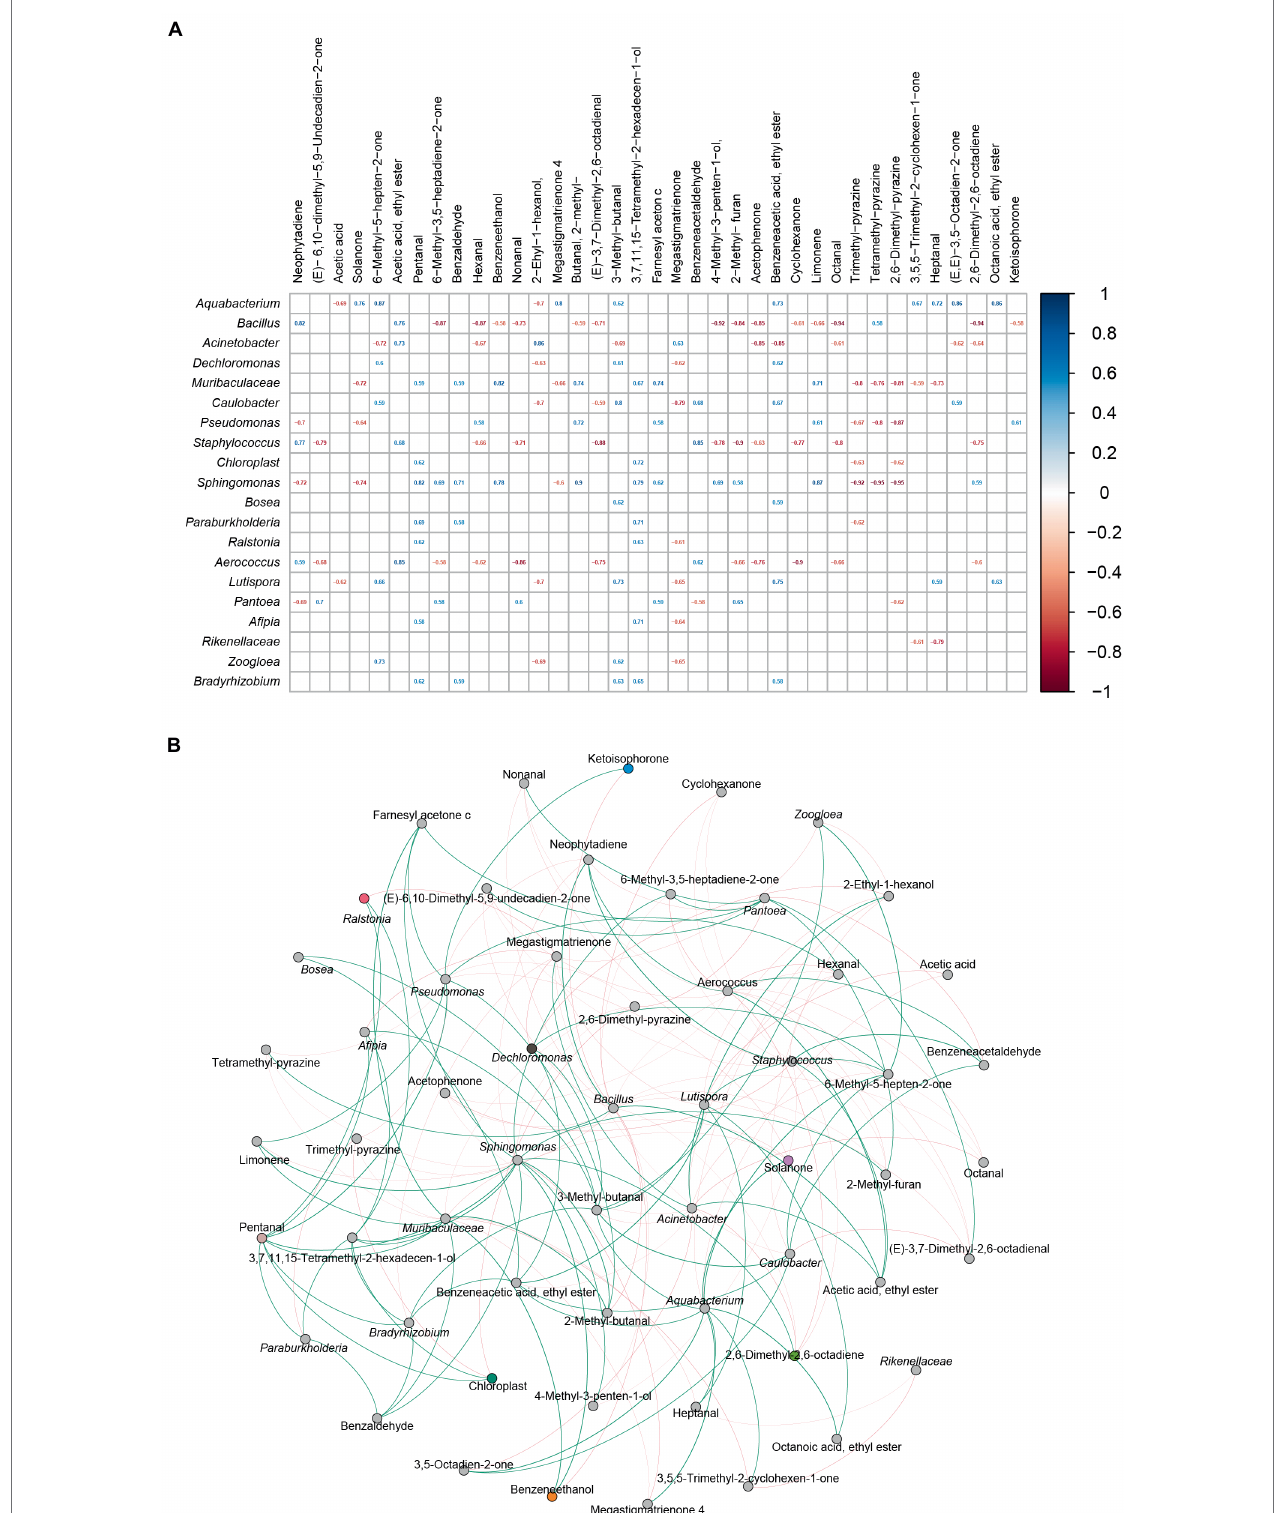
FIGURE 8 | The correlation between bacterial community and volatile flavor compounds. Heatmap analysis based on Spearman’s correlation coefficients between representative bacteria and core volatile flavor compounds (A) . Co-occurrence networks of representative bacterial taxa and core volatile flavor compounds. Green line means positive correlation; red line means negative correlation (B)